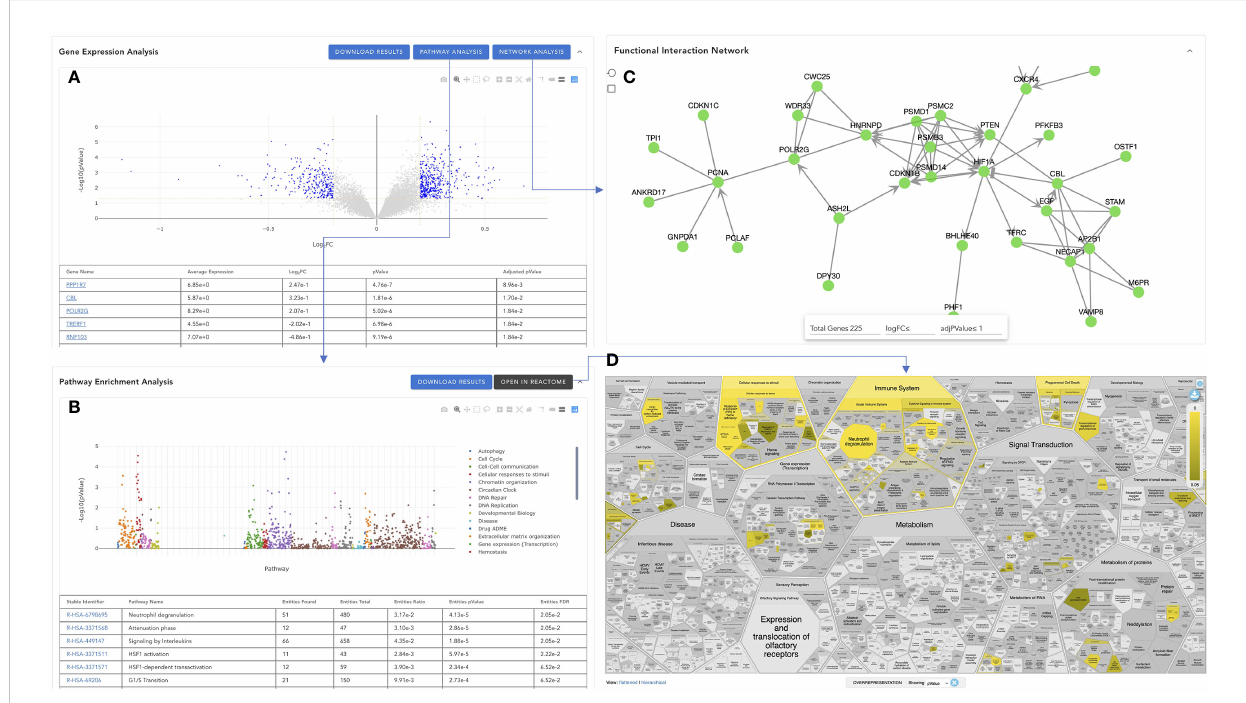
FIGURE 7 Visualization of the analysis results in VIGET. (A) Gene-wise differential expression analysis results widget to visualize the analysis results in a JavaScript-based volcano plot together with a table to show results for all genes. (B) Pathway-wise analysis results generated by Reactome ’ s pathway enrichment analysis for signi fi cant genes selected in A (genes plotted in blue in A). (C) Reactome functional interaction view of selected signi fi cant genes in (A) . (D) The pathway enrichment analysis can also be viewed directly inside the Reactome website by clicking the “ OPEN IN REACTOME ” button in